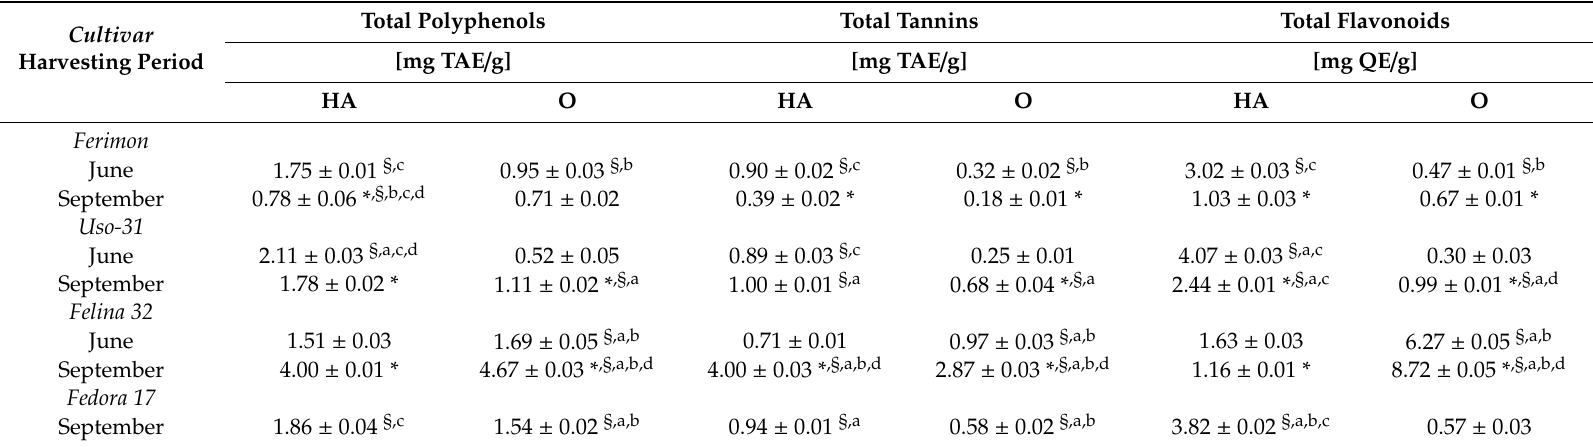
Table 4. Total polyphenols, tannins and flavonoids content in the hydroalcoholic (HA) and organic (O) Bligh-Dyer extracts obtained from the June and September harvested inflorescences of Ferimon, Uso-31, Felina 32 and Fedora 17 cultivars. Values were expressed as [mg / g of fresh sample] mean ± SD (standard deviation), n =